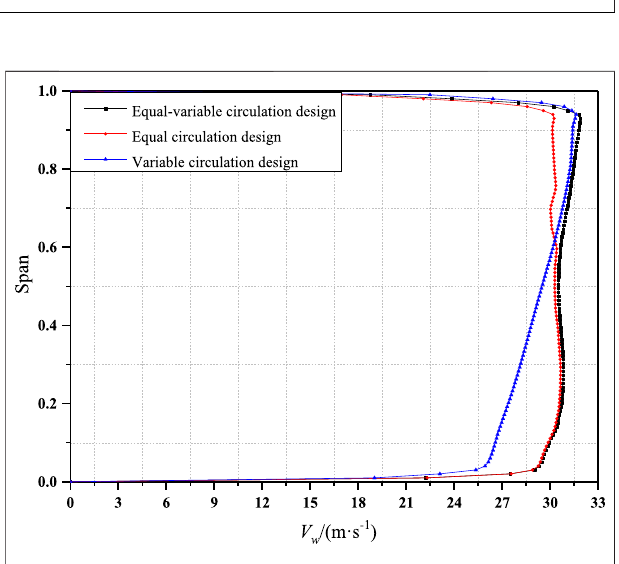
FIGURE 7 | Axial velocity comparison at the